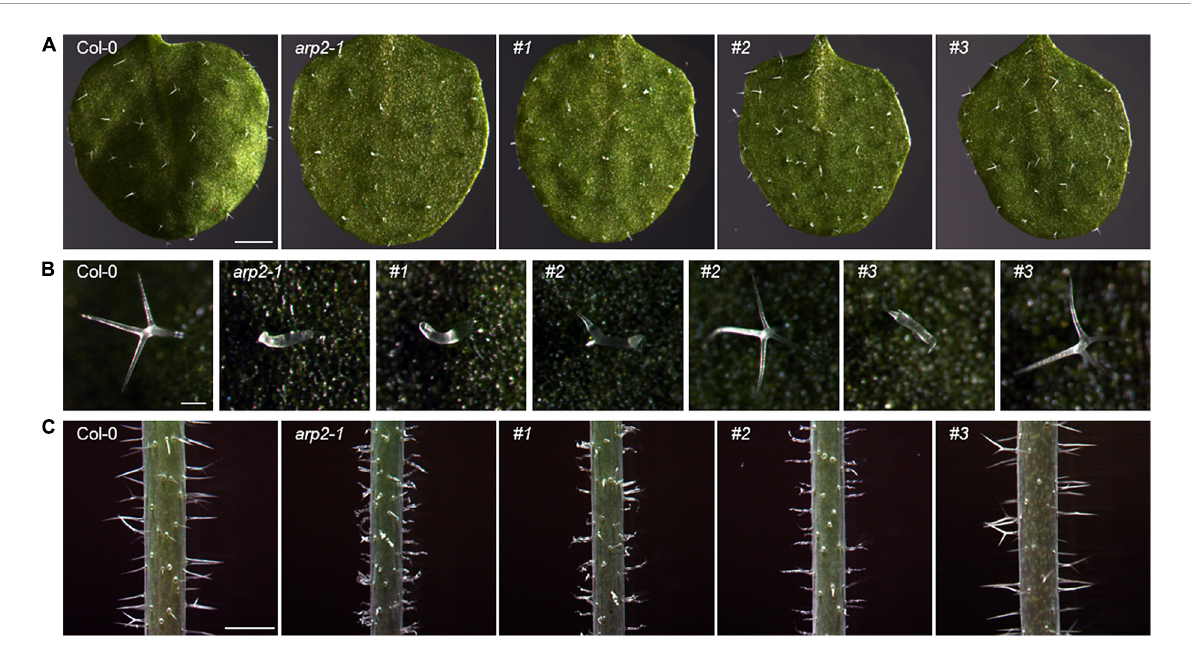
FIGURE1 Trichome phenotypes of Col-0 , arp2 T-DNA mutant, and CRISPR transgenic lines with GFP-PEN1 expressing background. (A) Overview of trichomes on the first true leaf from 2-week-old plants. Bars, 1 mm. (B) Single trichomes on the first true leaf from 2-week-old plants. Bars, 100 µ m. (C) Trichomes on stems from 4-week-old plants. Bars, 1 µ m. #1, #2, and #3 indicate three individual T1 generation CRISPR transgenic lines in the GFP-PEN1 expressing background.